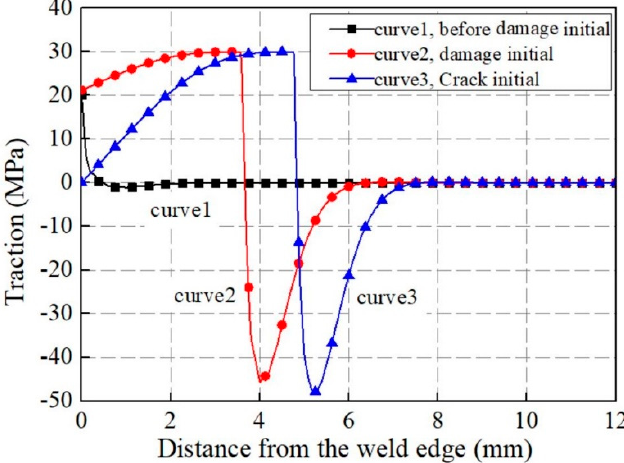
Figure 13. Traction distribution along the edge of the brazing seam at different damage stages of crack initiation.